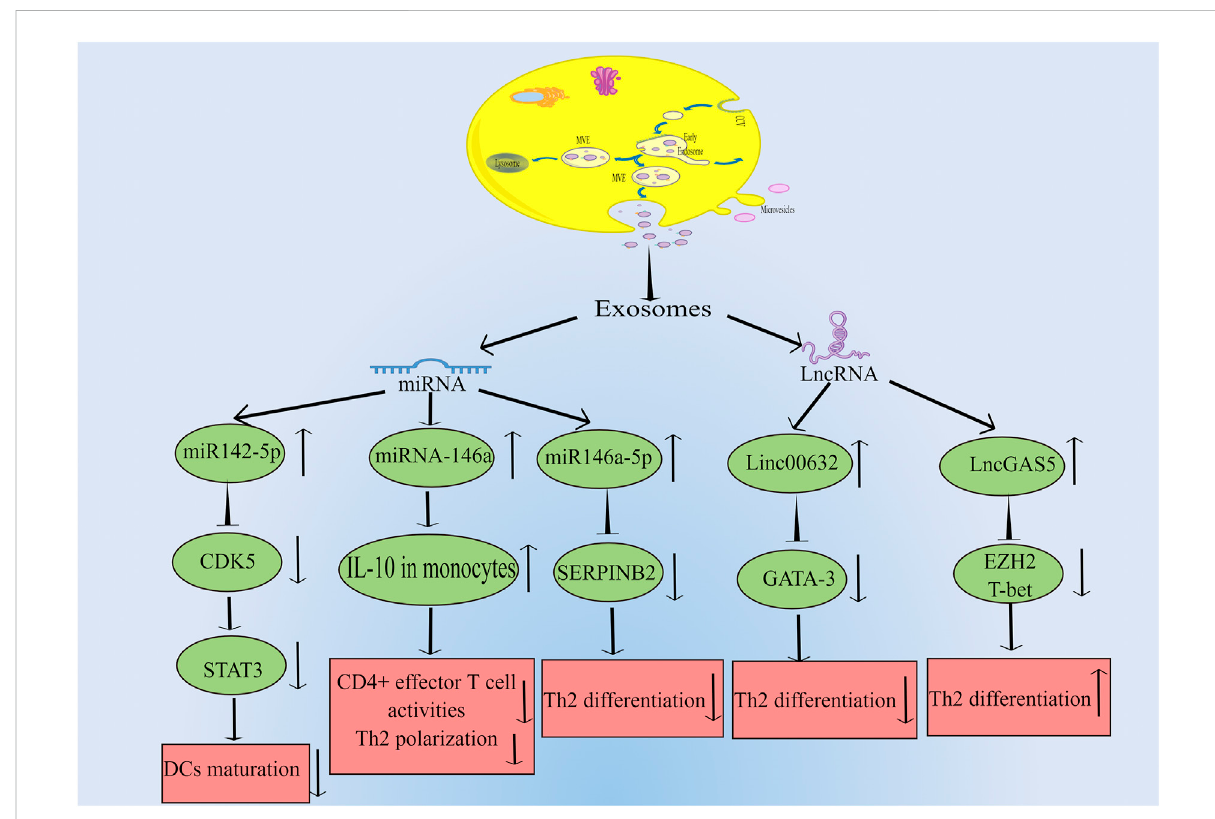
FIGURE 1 Exosomes can be produced by many kinds of cells, which can transmit intercellular signals through the release of miRNA and LncRNA, and